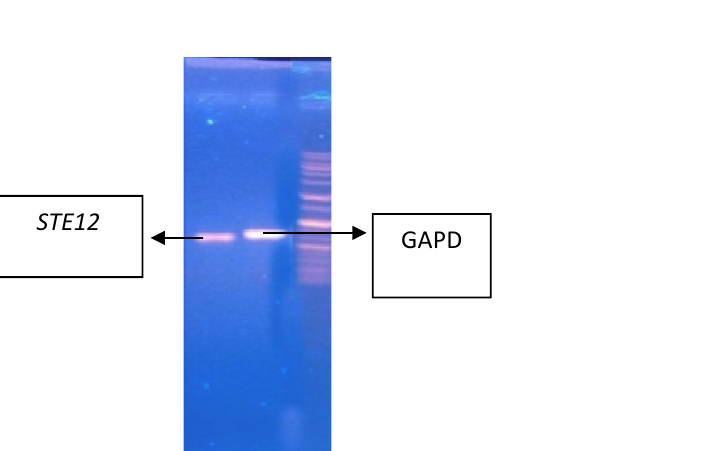
Figure 16. Agarose gel electrophoresis of GAPDH and STE12 genes amplified using DNA of P. herbarum.